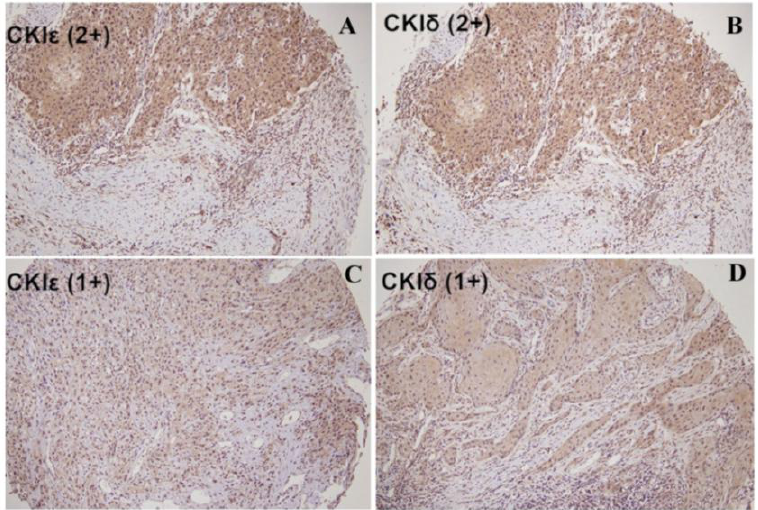
Figure 1. CK1ε and CK1δ immunoreactivity and CK1ε kinase activity in non-tumor oral squamous mucosa and SCC. ( A ) Strong cytoplasmic CK1ε expression in SCC (score